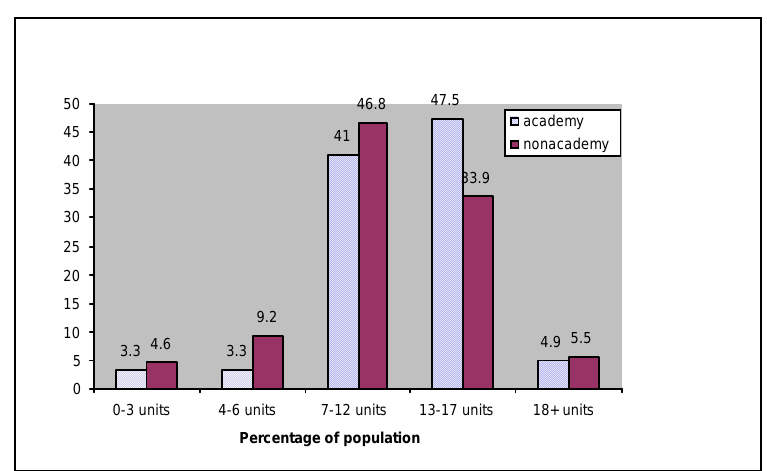
Number of college semester